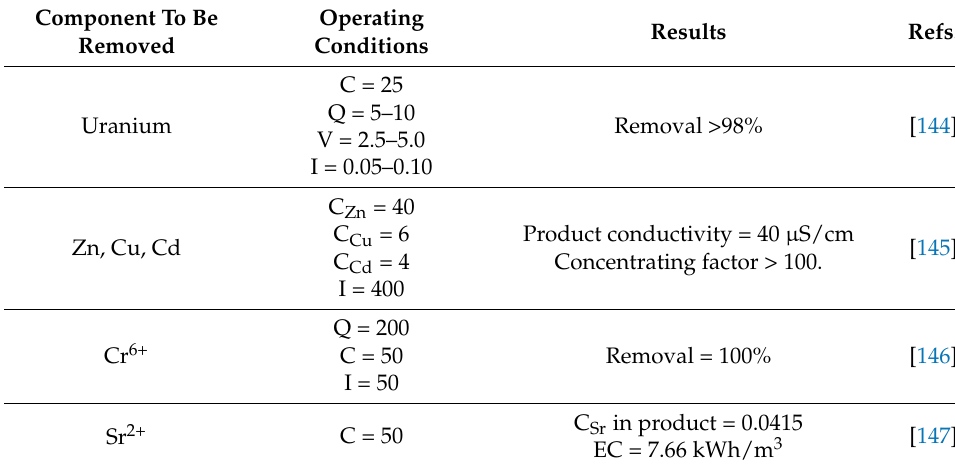
Table 6. Performances of EDI in heavy metal